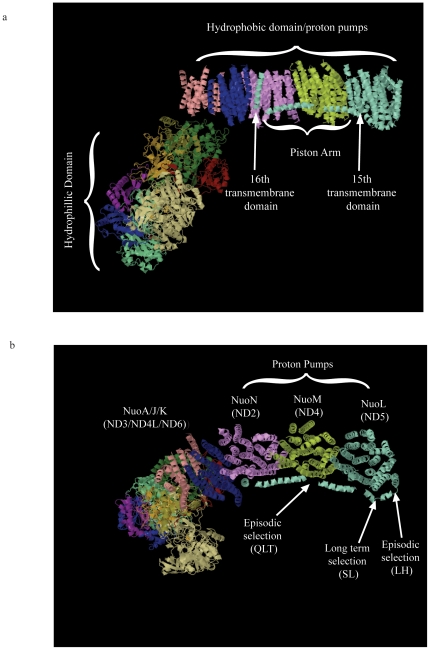
3-dimensional crystal structure of Complex I from E. coli.(a) Major domains of the complex. The hydrophobic domain contains the proton pumps and the recently discovered piston arm is identified. The 15th and 16th transmembrane domains that anchor the piston arm are also shown. (b) Individual proton pumps are labeled. Arrows point to the likely locations of sites under both episodic- and long-term selection and the amino acids from the O. tshawytscha sequence are given below each arrow (see Results).